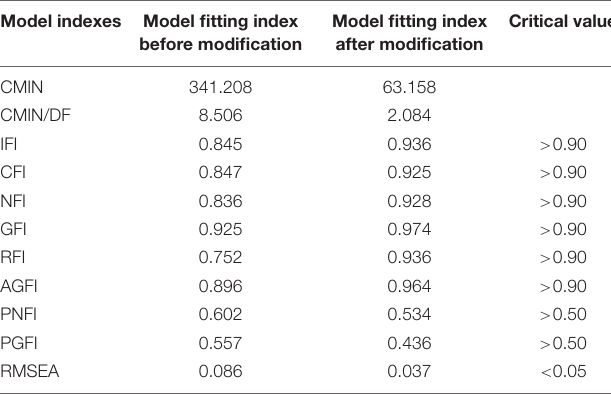
TABLE 10 | Fitting index of each model index.